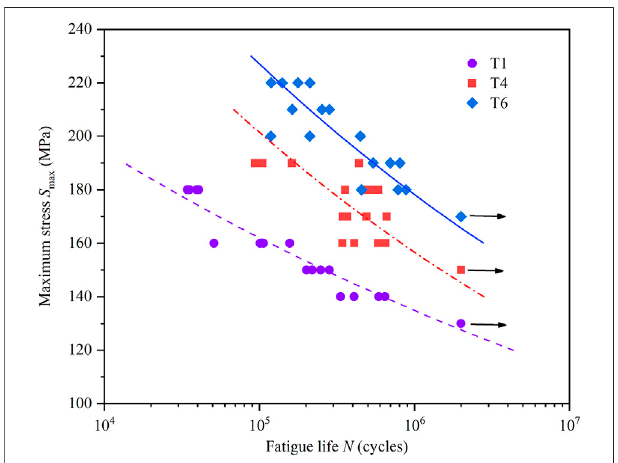
FIGURE 5 | S-N curves of the Al-12.7Si-0.7Mg alloy in different